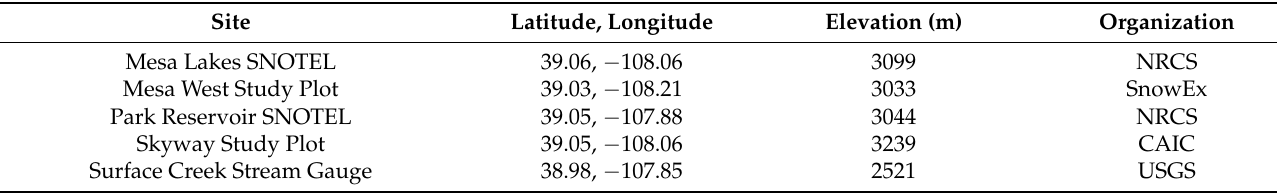
Figure 1. Grand Mesa, Colorado, USA. The study area is outlined in orange in the overview map (bottom right). Meteorological/SNOTEL sites, USGS stream gauge, SnowEx IOP, Time Series, and Pathfinder measurement sites are identified. Focus backscatter study areas in grassland/herbaceous and evergreen land covers are outlined. Table 1. Meteorological and streamflow sites